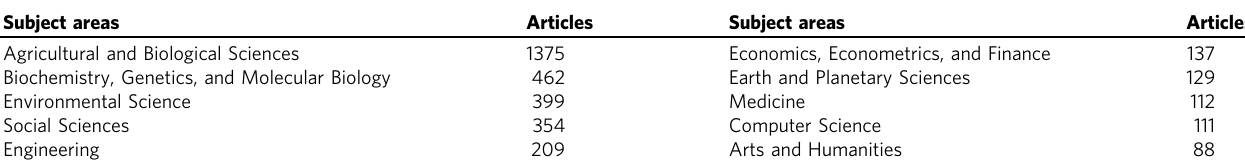
Table 2 Top 10 subject areas of rice research in Indonesia and the Philippines since 2001.